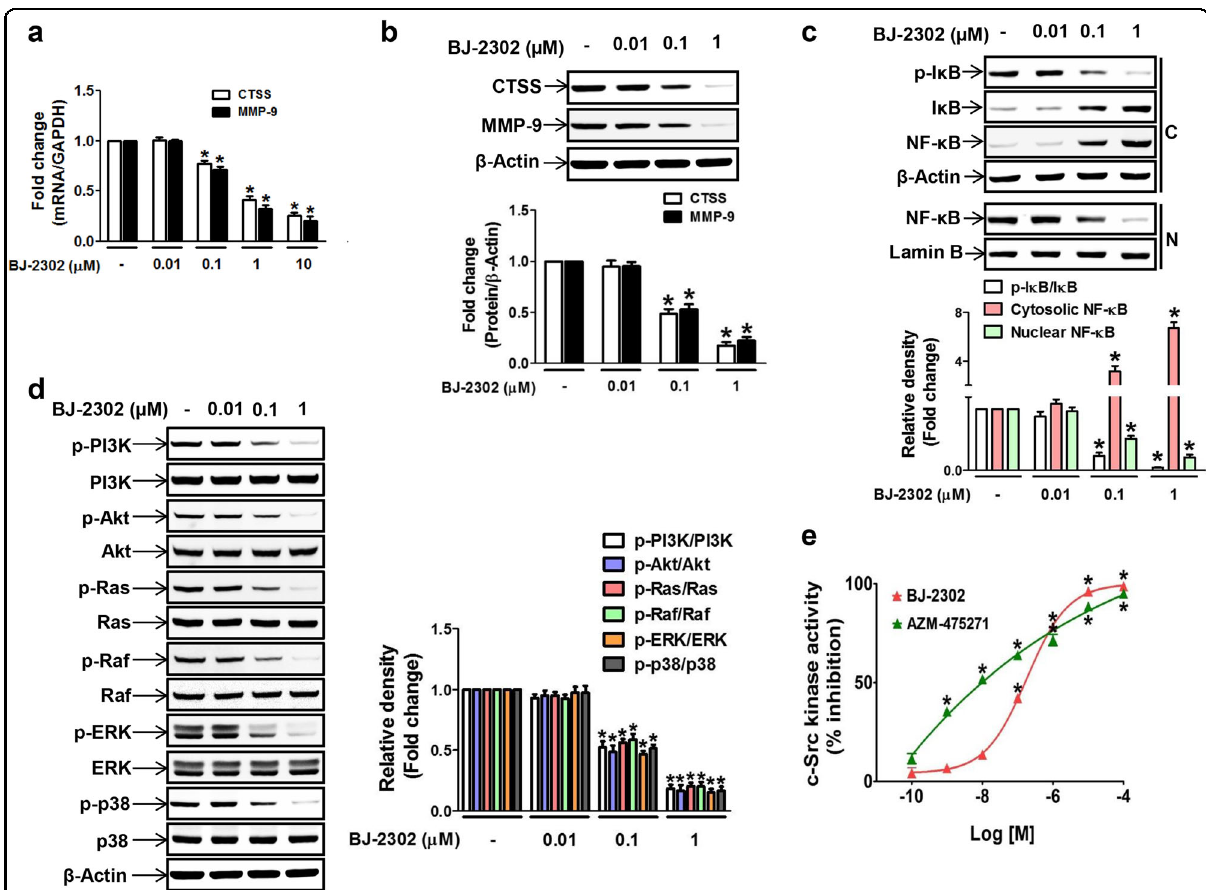
Fig. 5 Down-regulation of CTSS and MMP-9 expression by BJ-2302 via inhibition of Src and its down-stream signaling pathways, PI3K/Akt and Ras/Raf/ERK. a , b MDA-MB-231 cells were treated with the indicated concentrations of BJ-2302 and were examined for the mRNA ( a ) and protein levels ( b ) of CTSS and MMP-9. The bands are representative of three independent experiments, and the bar-diagram represents the mean ± S. E.M. * P < 0.05 compared to vehicle-treated cells. c , d Effect of BJ-2302 on NF- κ B nuclear translocation ( c ) and upstream molecules ( d ) related to the regulation of CTSS and MMP-9 expression. The bar-diagram represents quantitative data. * P < 0.05 compared to vehicle-treated cells. e Comparison of the inhibitory effect of BJ-2302 with AZM-475271 on Src kinase activity. * P < 0.05 compared to vehicle-treated